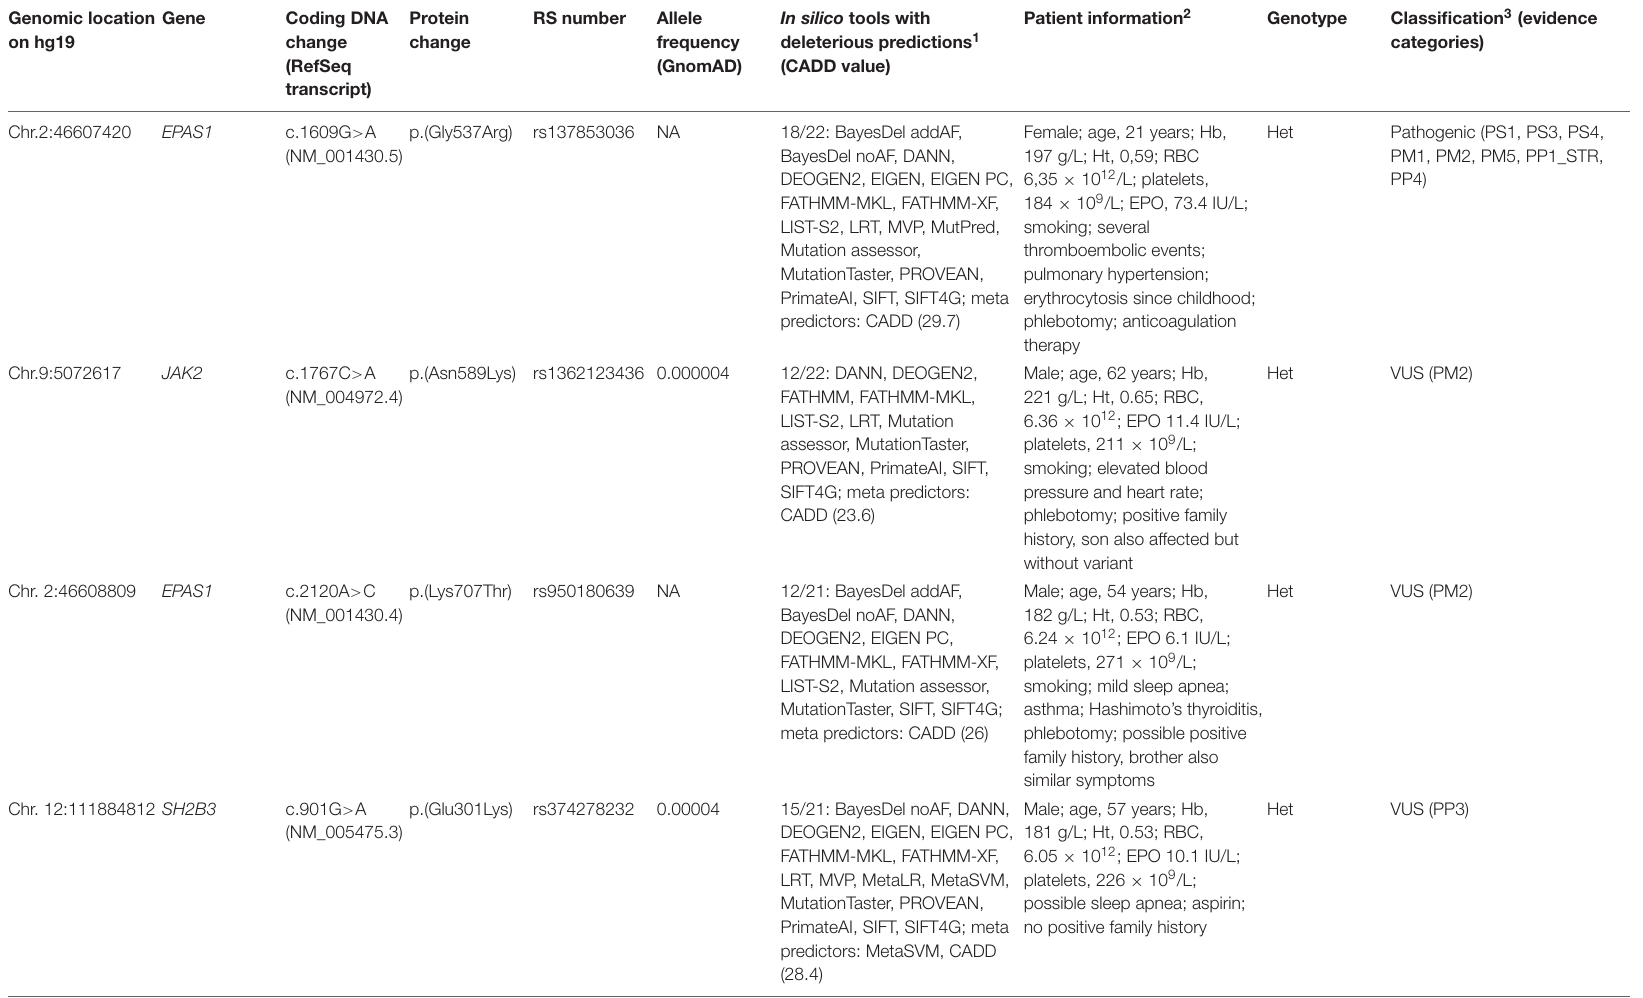
TABLE 1 | Known and novel variants detected in the known erythrocytosis genes. Genomic location on